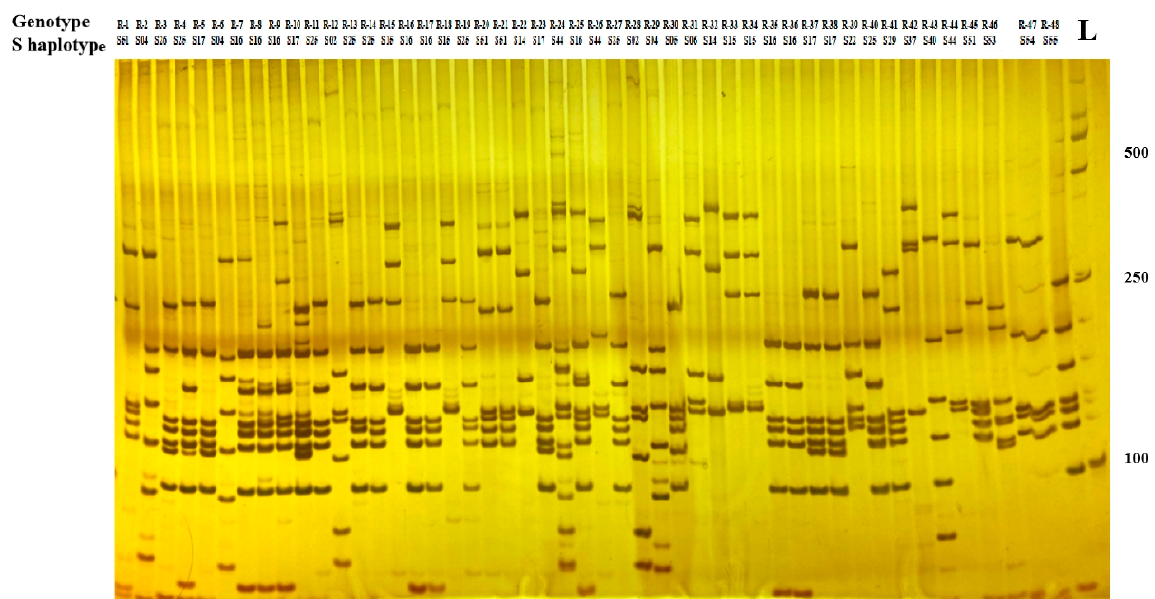
Figure 2. Polyacrylamide gel electrophoresis of PCR products after cleavage with Hin f I. L: 2000-bp ladders.